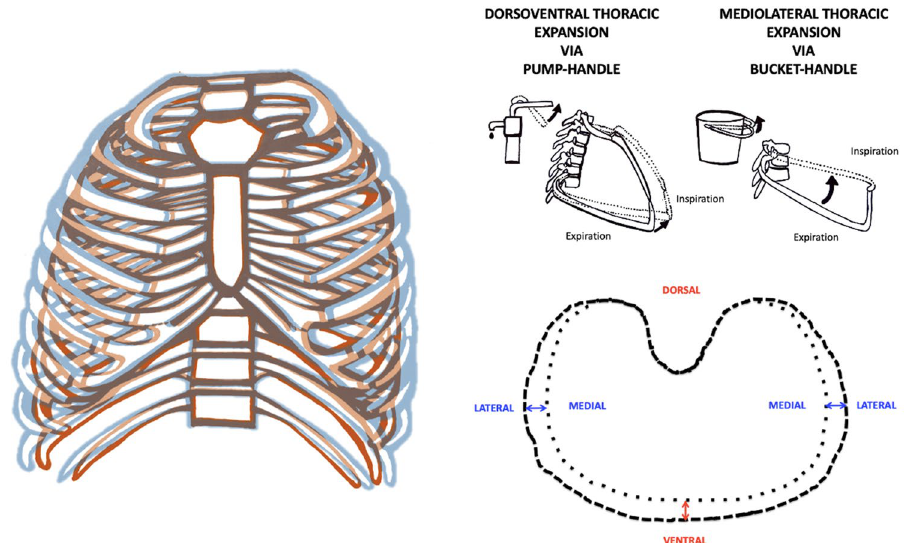
Figure 2. The thorax increases in volume during ventilation due to the action of the ribs through the pump- handle and bucket-handle motions. Changes in the maximum circumference of the thorax during ventilation result from the pump-handle (dorsoventral; red) and bucket-handle (mediolateral; blue) rib motions in